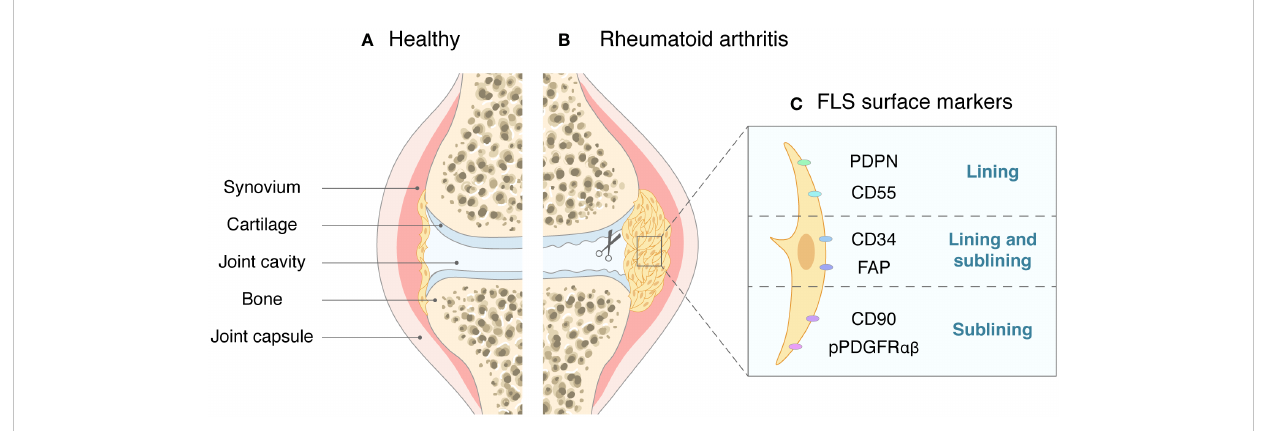
FIGURE 1 The synovial joint in health and in RA. (A) In healthy joints, the synovial tissue is sparse, with only one or two layers of cells. (B) In RA, synovial cells proliferate and become invasive, causing cartilage and bone to erode. (C) Surface markers of FLSs and their main